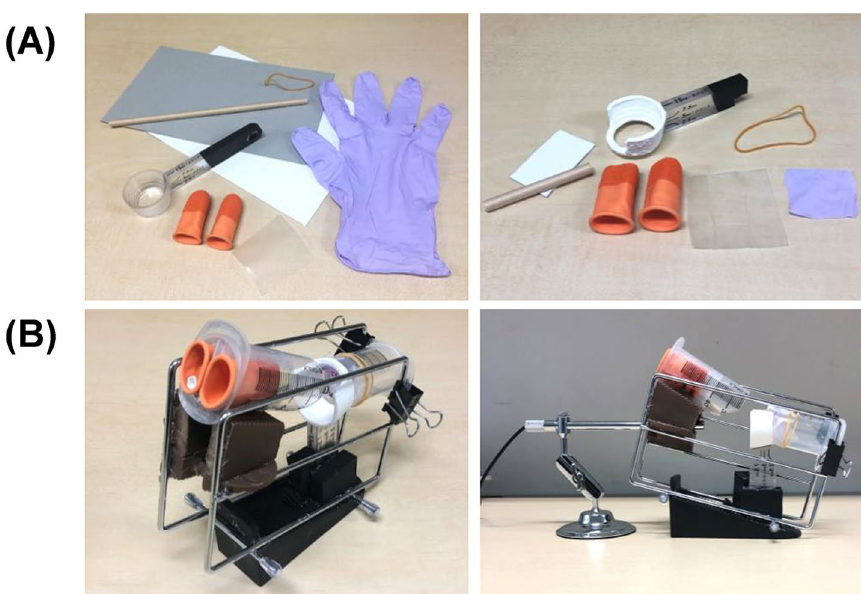
Figure 3. Other materials used for the training kit. ( A ) Materials for other objects. Left panel, before cutting; right panel, after cutting. The bottom of the measuring spoon was hollowed out, and the measuring part was colored white with paint to reproduce the sphenoid sinus. ( B ) After